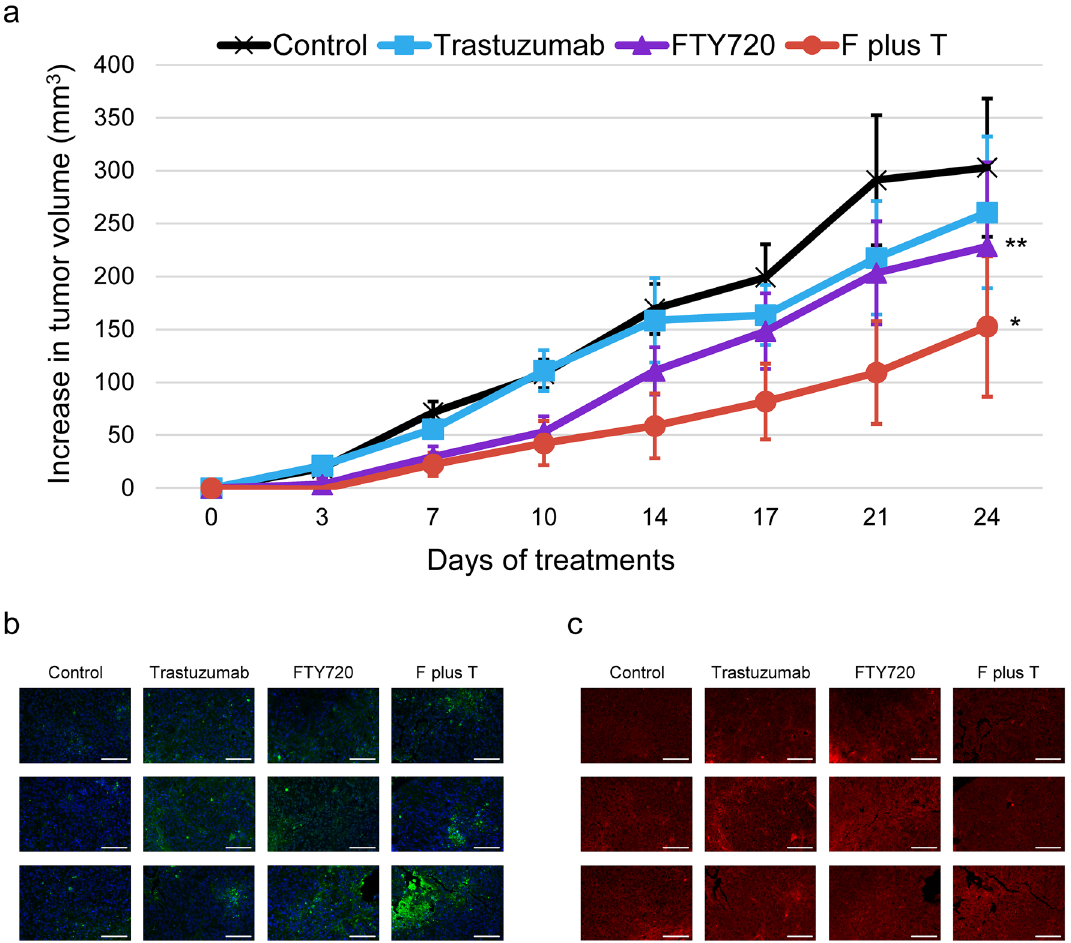
Figure 7. Xenograft mouse model of HCC1954 cells showing the efficacy of FTY720 with or without trastuzumab. ( a ) Mice bearing HCC1954 xenografts were randomized into four treatment groups (n = 9 for each group) when tumor size reached 150–200 mm 3 . Mice were treated with PBS, trastuzumab, FTY720, or FTY720 plus trastuzumab. Xenografts were harvested 24 h after the last treatment. Each plot indicates the mean increase in tumor volume from the first day of treatment, whereas error bars indicate the standard error of the mean. Differences between the four groups were analyzed using ANOVA with mixed-effect model. Differences in control versus FTY720 and control versus FTY720 plus trastuzumab were statistically significant. P value: * P < 0.05 and ** P < 0.01. ( b ) Tumor tissue sections were evaluated using TUNEL assays (green) and also counterstained with Hoechst 33,342 dye (blue, indicating nuclei). They were then examined using fluorescence microscopy. The top three tissue sections with the most abundant green signals in each group were presented. ( c ) Using the same tissue sections, cell membranes were outlined using HER2-antibody conjugating secondary antibody (red) and then examined using fluorescence microscopy. Bar, 100 μm. F plus T: FTY720 plus